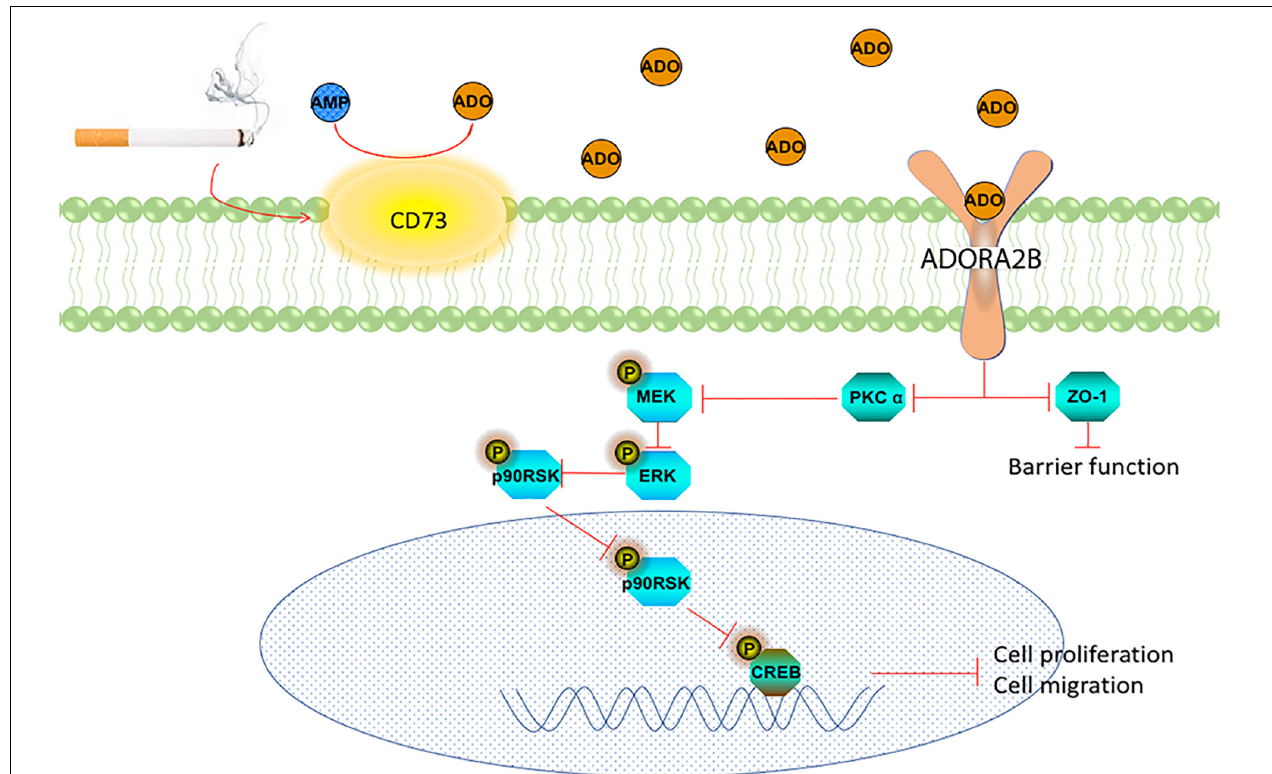
FIGURE 7 | Schematic representation of the role of CD73 and ADORA2B in CS impairment of wound repair in airway epithelial